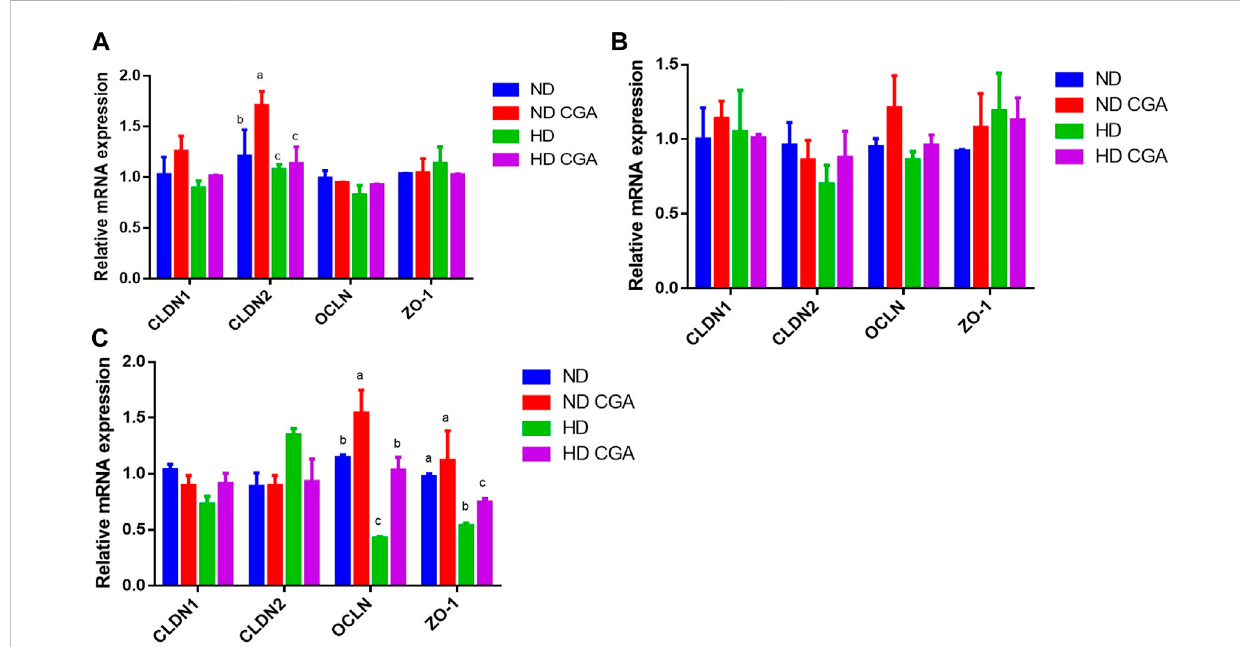
FIGURE 2 Effects of CGA on ileum mRNA expression of tight junction genes in broilers under HD stress. ND group, normal stocking density + basal diet; ND+CGAgroup,normalstockingdensity+basaldiet+0.15%CGA;HDgroup,highstockingdensity+basaldiet;HD+CGAgroup,highstockingdensity + basal diet +0.15% CGA. (A) Relative mRNA expression at day 28. (B) Relative mRNA expression at day 35. (C) Relative mRNA expression at day 42. Each vertical bar represents the mean ± SEM ( n = 10). Values with different letters within the same row are indicative of statistically signi fi cant differences ( p < 0.05, Tukey ’ s HSD test after one-way